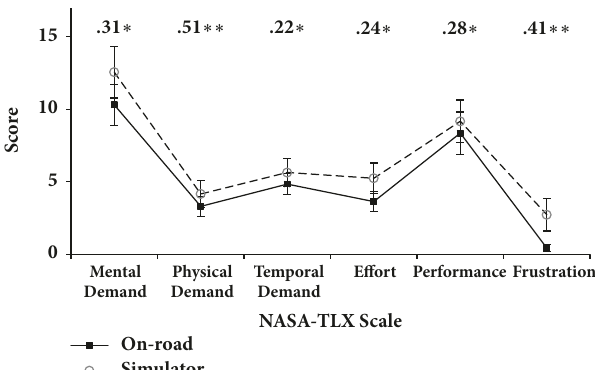
Figure 3: On-road vs. simulator mean score comparisons of subjec- tive measures of workload (NASA-Task Load Index scores). Figures inside the graph are Pearson's zero-order correlations between the scores in the simulator and scores on the road as an index of relative validity (n = 87). ∗ : p < 0.05 and ∗∗ p <